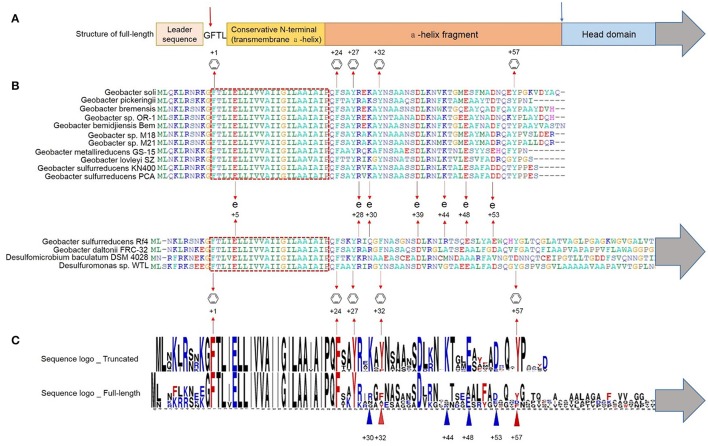
Multiple alignment of truncated and full-length pilins of Geobacter. The gray arrows indicate the presence of the C-termini sequences of the full-length pilins (Supplementary Figure S2). (A) Schematic representation of the structure of a full-length pilin. The red arrow indicates the peptidase splice site, and the blue arrow indicates the truncation site. (B) The conserved transmembrane domain is shown in the red dotted box.  and + indicate the conserved aromatic amino acids and charged amino acids respectively. (C) Sequence logos of truncated (GSU1496-like) and full-length pilins in Geobacter. Red and blue triangles indicate aromatic amino acids and charged amino acids respectively.